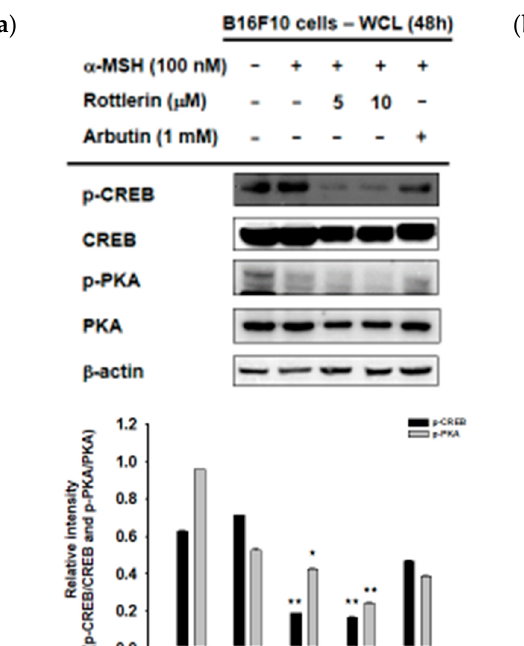
Figure 4. Rottlerin inhibits melanogenesis via the cAMP / CREB signaling pathway. ( a ) B16-F10 cells (10 5 cells / mL) were activated by α -MSH in the presence or absence of rottlerin (5 and 10 µ M) or arbutin (1 mM) for 48 h. Phosphorylated and total CREB were evaluated by immunoblotting. ( b ) Intracellular cAMP levels were analyzed using a cAMP immunoassay kit. All data ( b ) are expressed as the mean ± SD of three replicates. WCL: Whole cell lysates. * p < 0.05 and ** p < 0.01 compared to control groups.